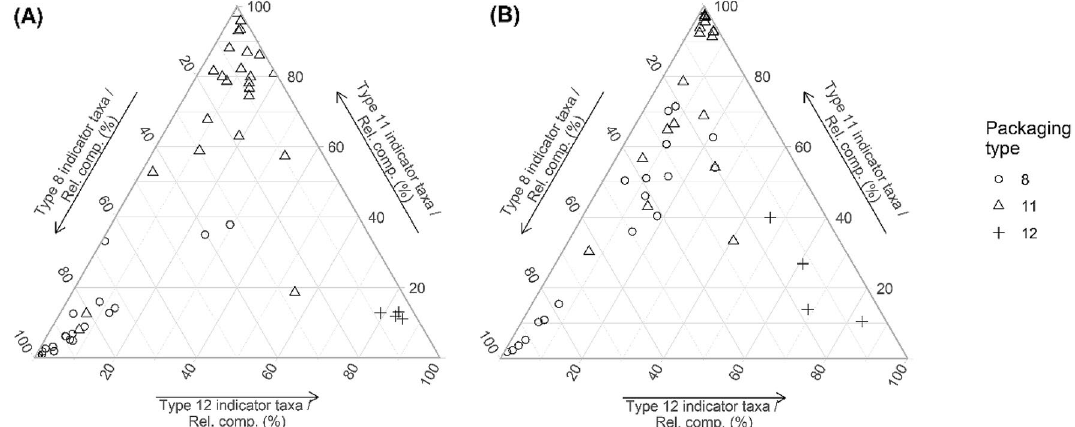
Figure 4. Ternary plots of the percent relative composition of ( A ) bacterial and ( B ) eukaryote indicator taxa for packaging Type 8 (n = 20 tablets), Type 11 (n = 24 tablets), and Type 12 (n = 4 tablets). Indicator taxa were derived by pooling all significantly increasing and decreasing taxa identified within respective contrasts (Type 11 vs. 8, Type 11 vs. 12, Type 12 vs. 8) in DESeq2 differential abundance testing, at an alpha level of 0.001. Note that the % relative composition values displayed here represent scaled data as the relative abundances of indicator taxa for the three packaging types are scaled up to 100% (considering indicator taxa